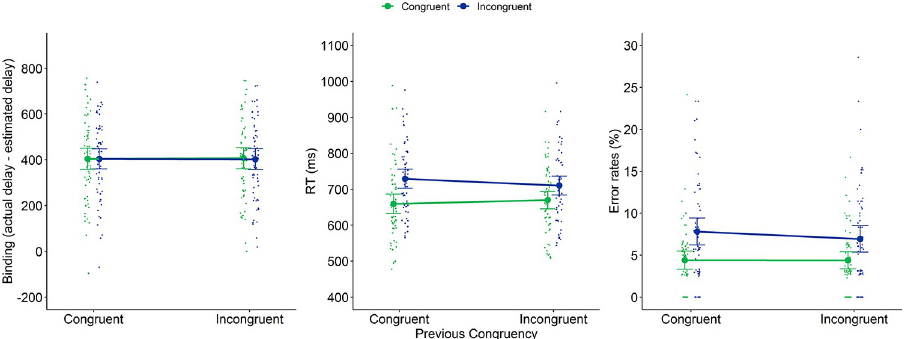
Fig 2. Intentional binding (left panel), RTs (middle panel) and error rates (right panel) of Experiment 1 as a function of previous congruency and current congruency. Dots represent mean RTs for each participant in each condition (thus, each participant is depicted four times on this graph, once for each Previous × Current Congruency condition). Error bars represent 95% confidence intervals.